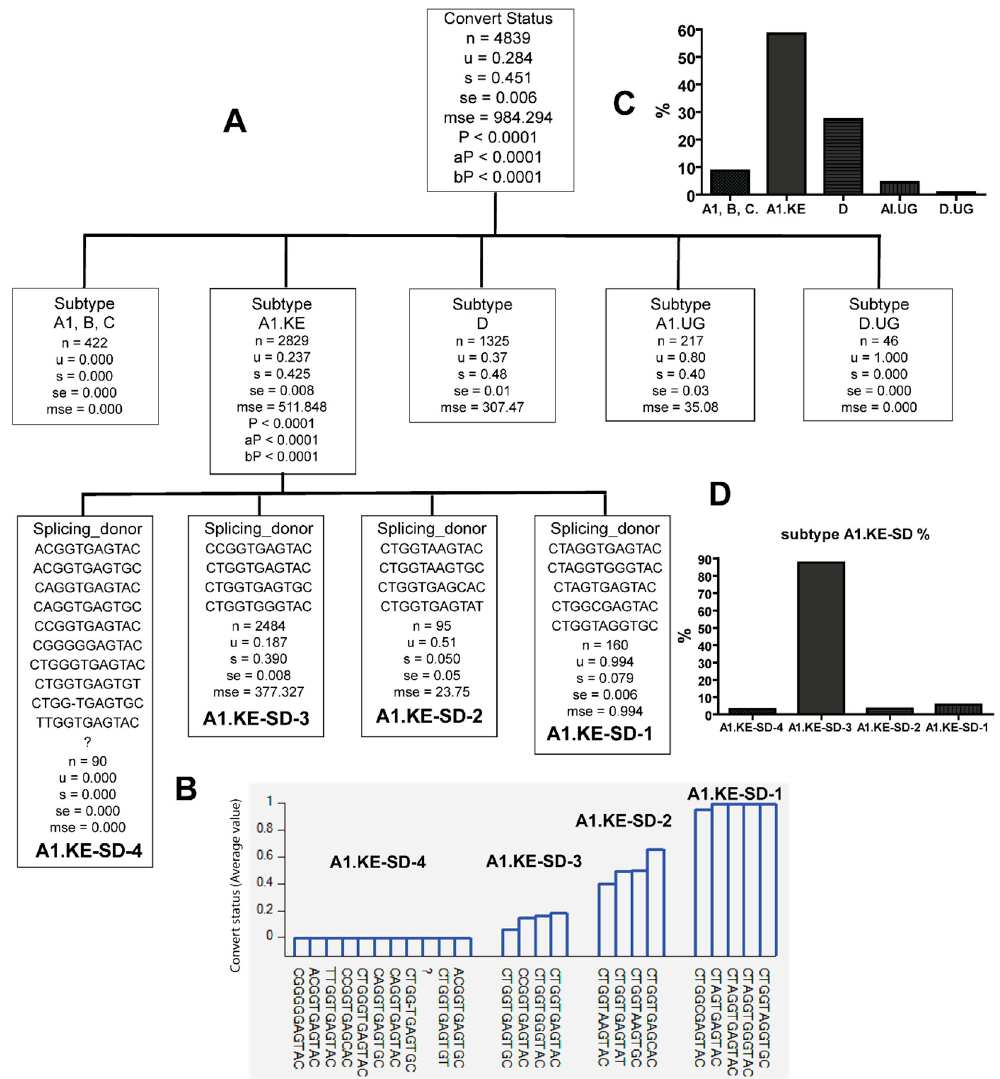
Figure 10. The combination of HIV subtype A1.KE and splicing donor sequences (SD) identified SD sequences only in either late ( u = 1) or early seroconverters ( u = 0). ( A ) HIV subtype A1.KE in tree node of subtype A1.KE was further classified with SD sequence variants based on whether they were identified from late or early seroconverters. ( B ) The figure shows u value of sequence combinations based on whether the subtype A1.KE-SD combinations were identified from late (1) or early (0) seroconverters. Note: n— counts (clone); u— mean value; s—standard deviation; se—standard error; mse—mean square error; p—p value; aP—adjusted p value; bP—Bonferroni corrected p